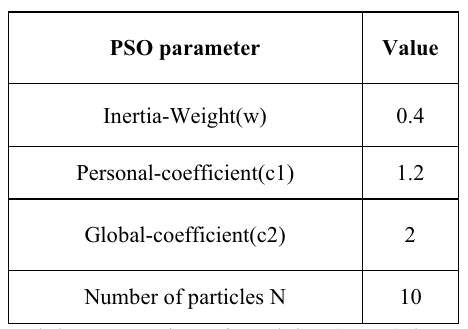
Fig. 11. Comparison between PSO and Perturb and Observe technique (scenario